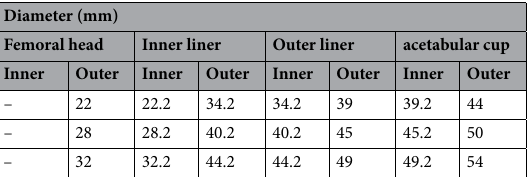
Table 1. Geometry size of the dual-mobility hip joint prosthesis